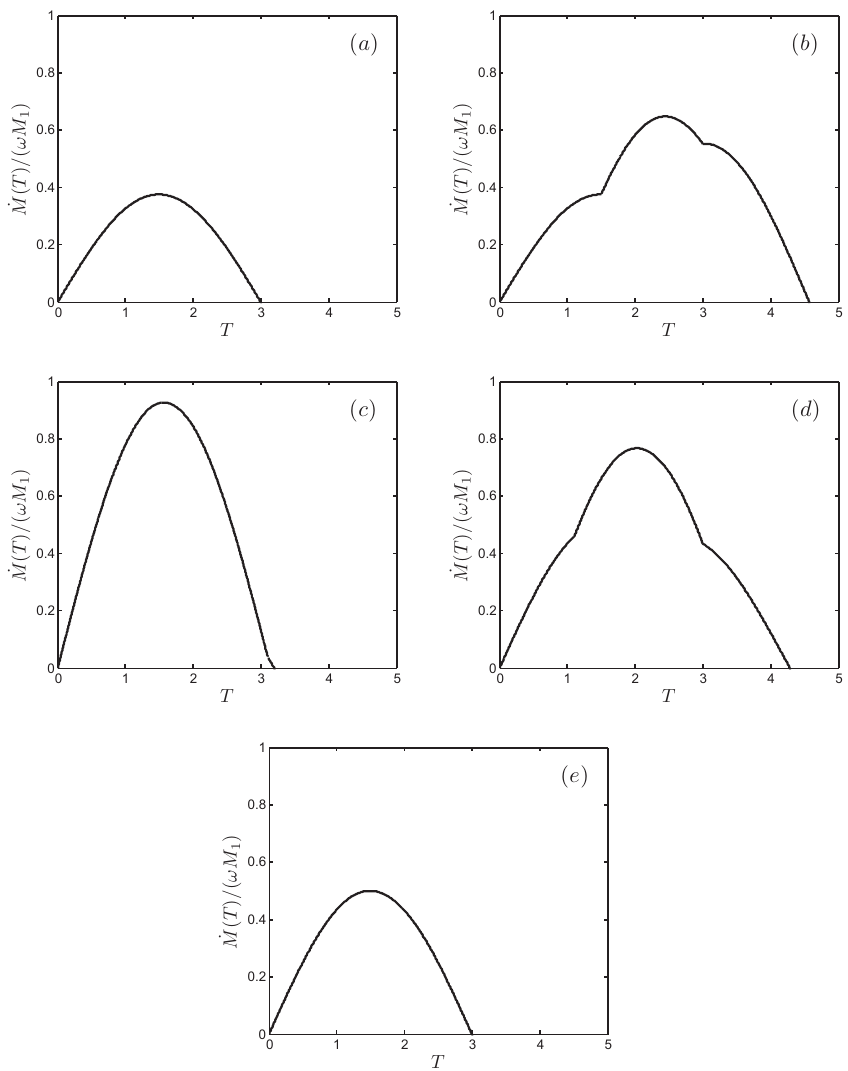
Figure 6. Examples of possible moment rates ˙ M(T ) for the event following the 10–01 event: (a) − 4.55 ≤ Z 1 < 0.20, (b) Z 1 = 0.30, (c) Z 1 = 0.41, (d) Z 1 = 0.60, and (e) 0.70 ≤ Z 1 ≤ 2.86, where Z 1 characterizes the initial state of the system. The values of